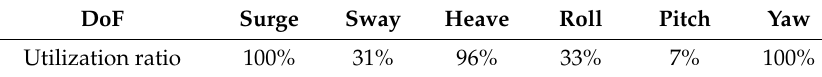
Figure 9. 3D model of SURIII.